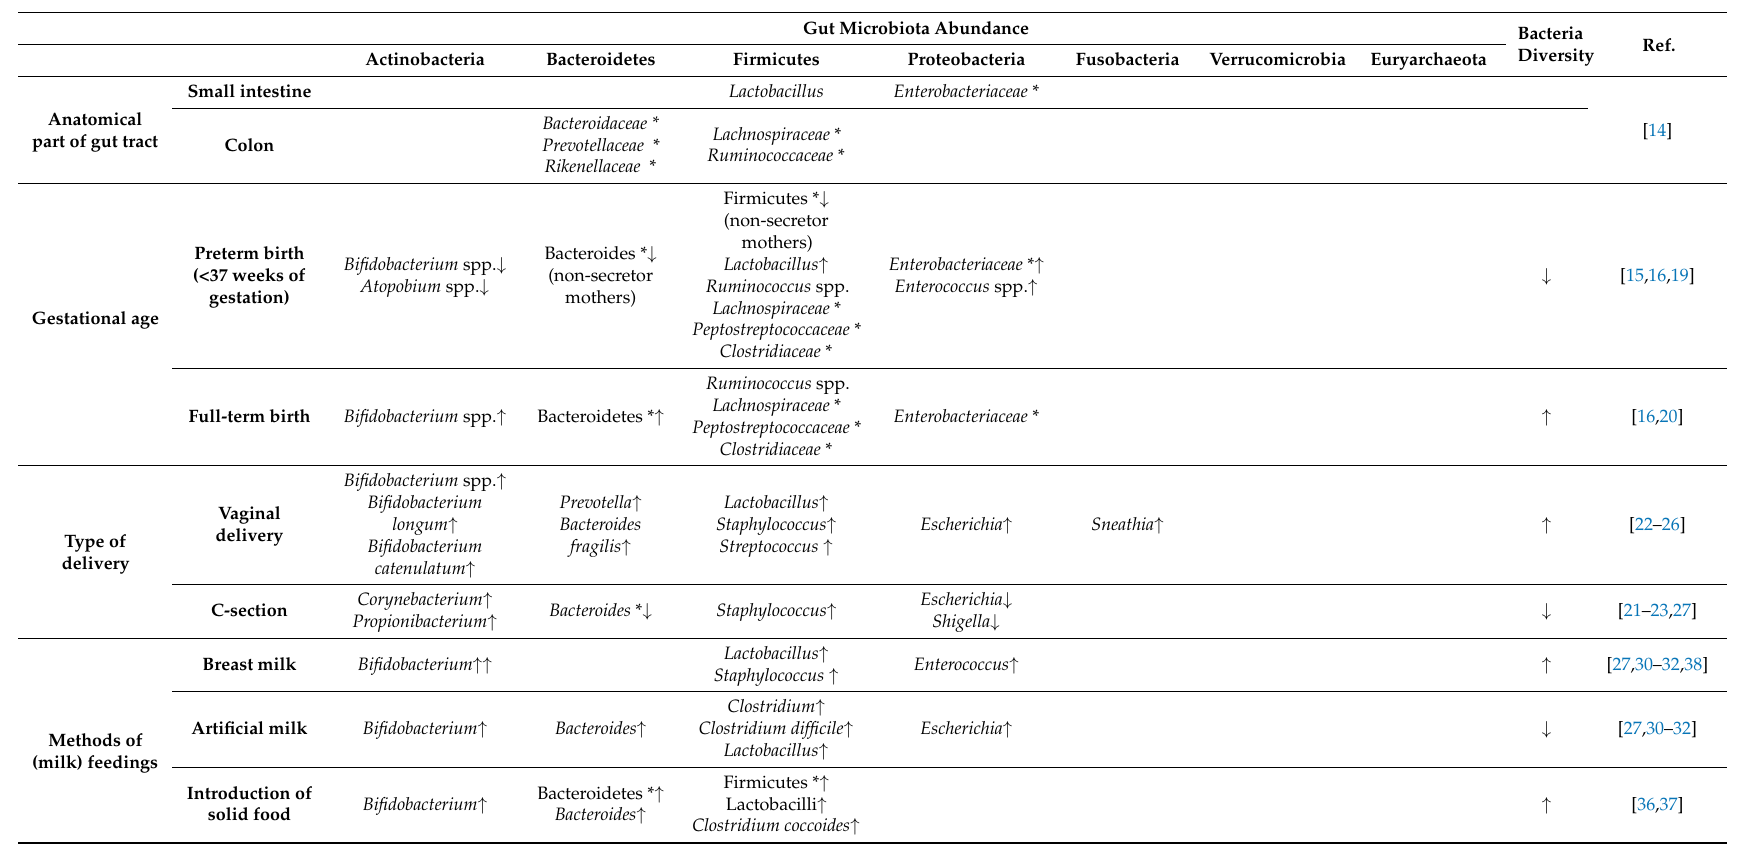
Table 1. Microbiota variations within